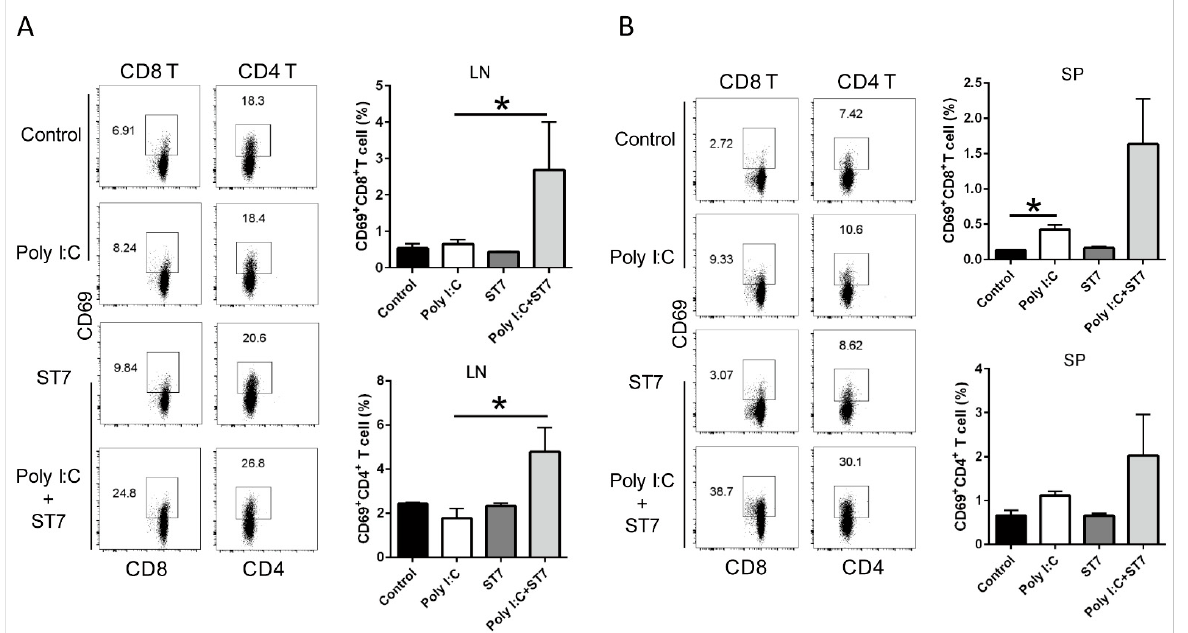
Figure 6. ST7 treatment promotes the activation of T cells after poly I:C stimulation. ( A ) The expres- sion of CD69 by CD8 + T and CD4 + T cells in the mesenteric lymph nodes (LNs) and ( B ) spleen (SP) after 2 h of poly I:C stimulation was analyzed using flow cytometry. The percentages of CD69 + CD8 + T and CD69 + CD4 + T cells in LNs and SP are depicted as bar graphs. Data are presented as mean ± standard error of the mean (SEM). n = 5 per group, * p < 0.05.